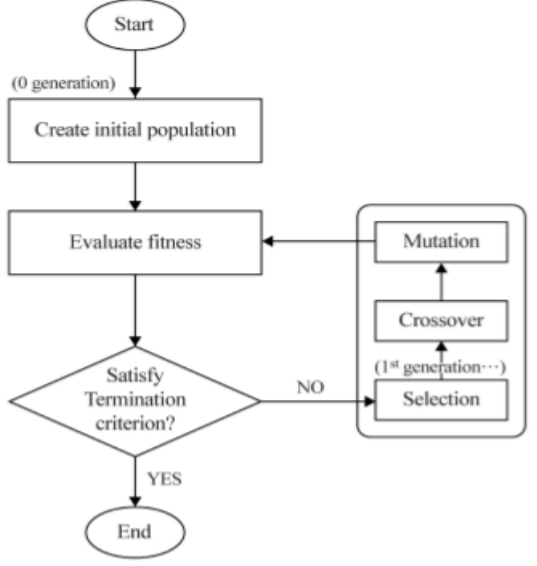
Figure 10. A flow chart for MOO method to predicting welding parameters.